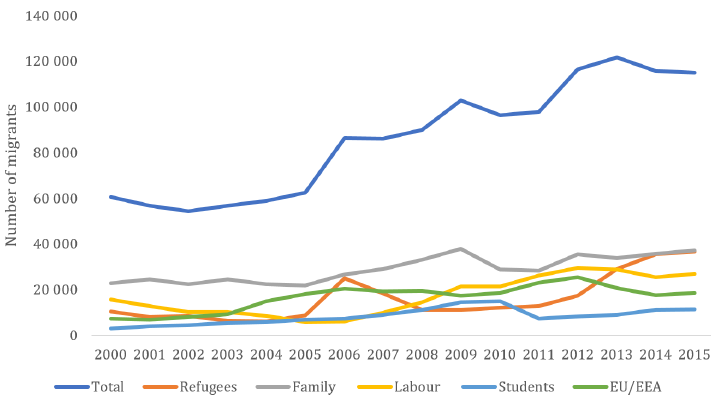
Figure 3: Foreign-born migration to Sweden by reason for